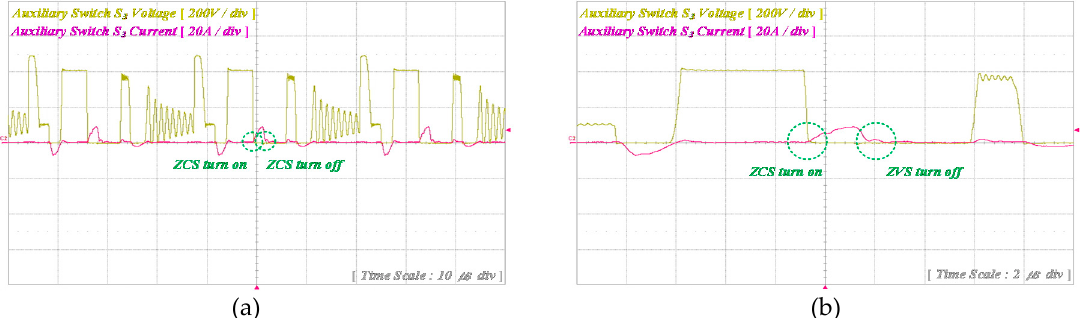
Figure 22. ( a ) Waveforms of auxiliary switch S 3 voltage and current and ( b ) expansion waveforms of S 3 . The input / output voltage and current waveforms are shown in Figure 23. A voltage step-up occurs from an input voltage of 200 V to an output voltage of 380 V, indicating good control of the output voltage.